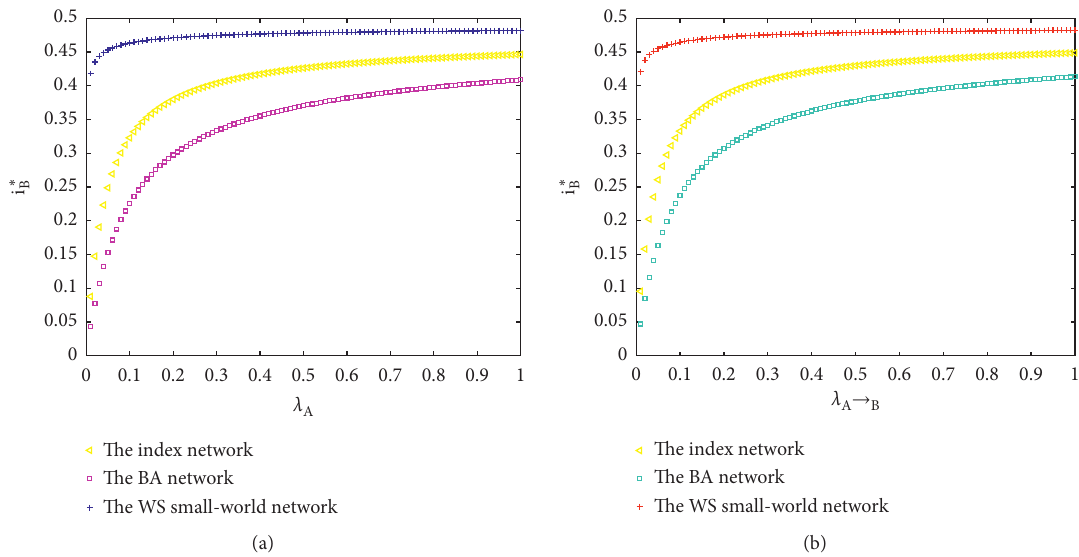
Figure 10: Evolutionary characteristics of bank counterparty credit risk contagion scale i ∗ B . (a) The influence of the credit risk contagion rate λ A of the counterparty of the enterprise credit-related network on i ∗ B in the bank network under different network structures. (b) The of the credit risk of corporate credit-related networks to the bank network on i ∗ B in the bank influence of risk contagion probability λ A ⟶ B network under different network